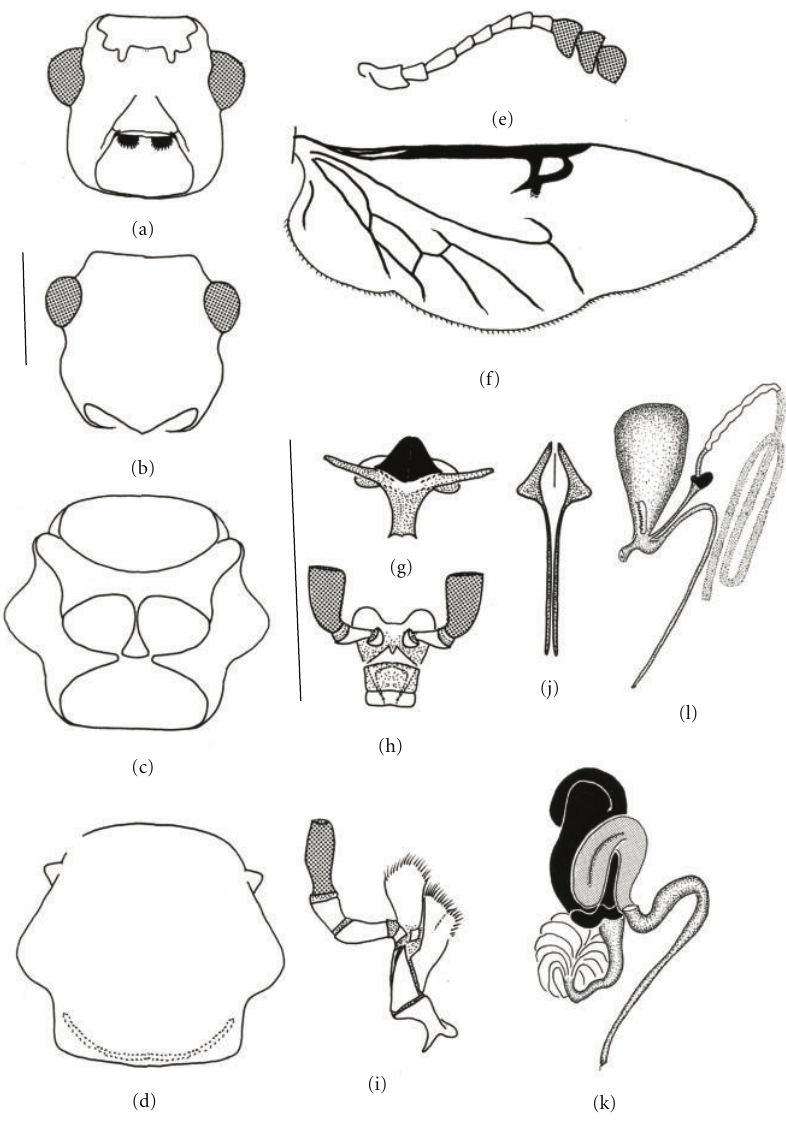
Figure 11: Various organs of Parapylus bicinctus . (a, b) Head ((a) ventral, (b) dorsal). (c, d) Pronotum ((c) ventral, (d) dorsal). (e) Antenna. (f) Metathoracic wing. (g) Metendosternite. (h) Labium. (i) Maxilla. (j) Spiculum. (k) Male mesodermal reproductive organs. (l) Female mesodermal reproductive